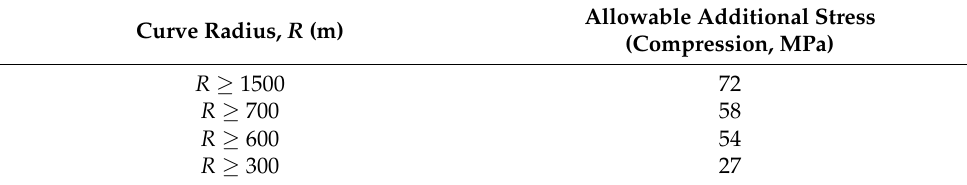
Table 1. Allowable additional stress standard according to a ballasted track (KR code). Curve Radius, R